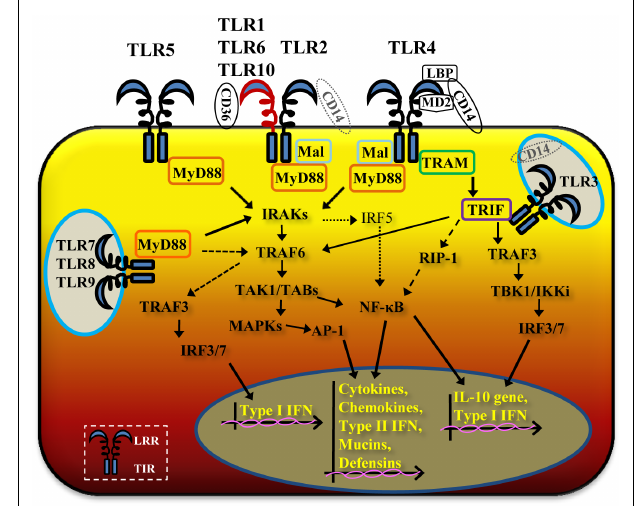
FIGURE 1 | Schematic cartoon ofTLR signaling pathways .TLR2/TLR1 andTLR2/TLR6 heterodimers andTLR4 andTLR5 homodimers are located on the cell surface, whileTLR3,TLR7,TLR8 andTLR9 homodimers have an intracellular localization. Occasionally, in specific epithelial cell types and tissues,TLR4 can be expressed intracellularly orTLR3 andTLR9 on the cell surface. Ligand binding to the leucine-rich repeat (LRR) domain ofTLR dimers brings theTIR domains of adjacentTLRs in proximity, allowing multiple signaling pathways via different adaptor molecules.TLR2/TLR1 and TLR3 potentially cooperate with CD14,TLR2/TLR6 with CD36 andTLR4 requires LBP, CD14 and MD-2.TLR1,TLR2,TLR4,TLR5,TLR6,TLR7,TLR8 andTLR9 activate the MyD88-dependent pathway, with cooperation of Mal forTLR2 andTLR4.Through MyD88, IRAKs andTRAF6,TLR2/TLR1 and TLR2/TLR6,TLR4,TLR5,TLR7,TLR8, andTLR9 signaling pathways lead to activation of NF- κ B and MAPKs, with production of inflammatory cytokines and chemokines, type-II interferon, mucins, and defensins (solid thick arrows).TLR7,TLR8, andTLR9 also induce MyD88-dependent activation of TRAF6 andTRAF3 (dashed arrows).TLR3 andTLR4 activate a MyD88-independent pathway viaTRIF and, in cooperation withTRAM for TLR4 (solid medium arrows), also leading to NF- κ B and MAPKs activation and of inflammatory mediators, type-II interferon, mucins, and defensins.The MyD88-independent pathway also induces IRF3 and IRF7 activation, with production of type-I IFNs and IL-10 gene